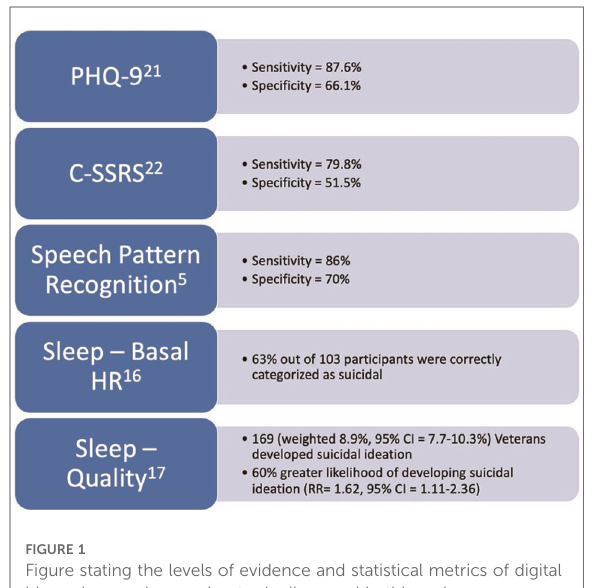
FIGURE 1 Figure stating the levels of evidence and statistical metrics of digital biomarkers and screening tools discussed in this